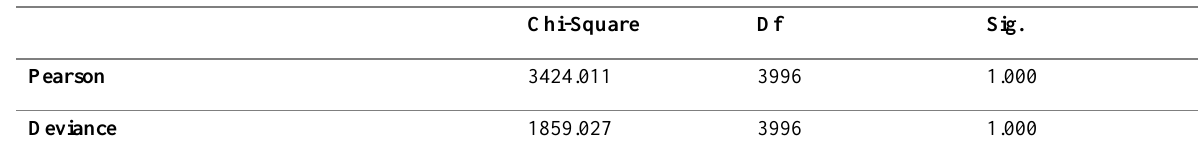
Table 3: Goodness-of-Fit